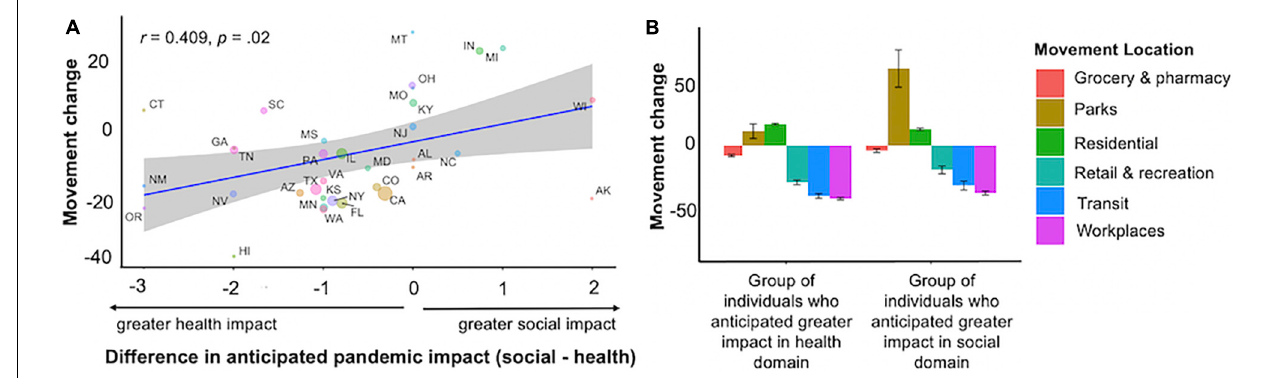
FIGURE 3 | Relation between average individual ratings of expected impact by participants in a given geographic area (each state) and average movement change from baseline in that geographic area. Baseline was obtained from January 3, 2020-February 6, 2020 by taking the median value for each day. Error bars represent standard error of the mean. (A) People residing in states where health, relative to social, impact was estimated to be more severe were more likely to show less movement across the course of the pandemic, whereas people residing in states where social, relative to health, impact was estimated to be more severe were less likely to curb movement. (B) People who expected higher social impact spent more time in other locations and less time near home relative to those who expected a high health impact. For illustration, the graph depicts a group-based split of the data (higher expected impact for social domain group had social-health difference scores > 1, higher expected impact for health domain group had social-health difference scores < 1); the body of the manuscript reports correlations including the full range of difference